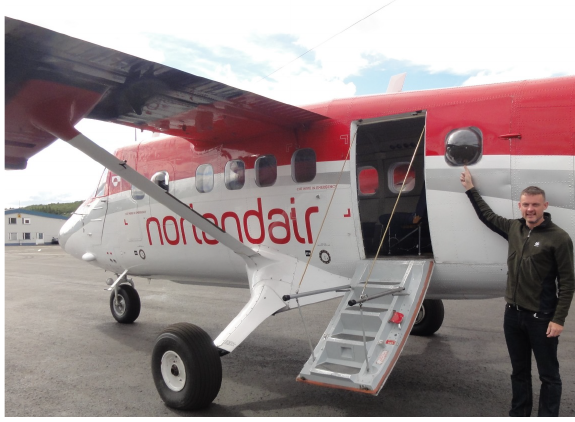
Figure 5. Bubble windows to ensure observers have unobstructed views ahead and under the plane (Photo: R. G. Hansen). IN THE MIDDLE OF THE WAVES BUT OUTSIDE WAVELENGTH Geneviève Desportes